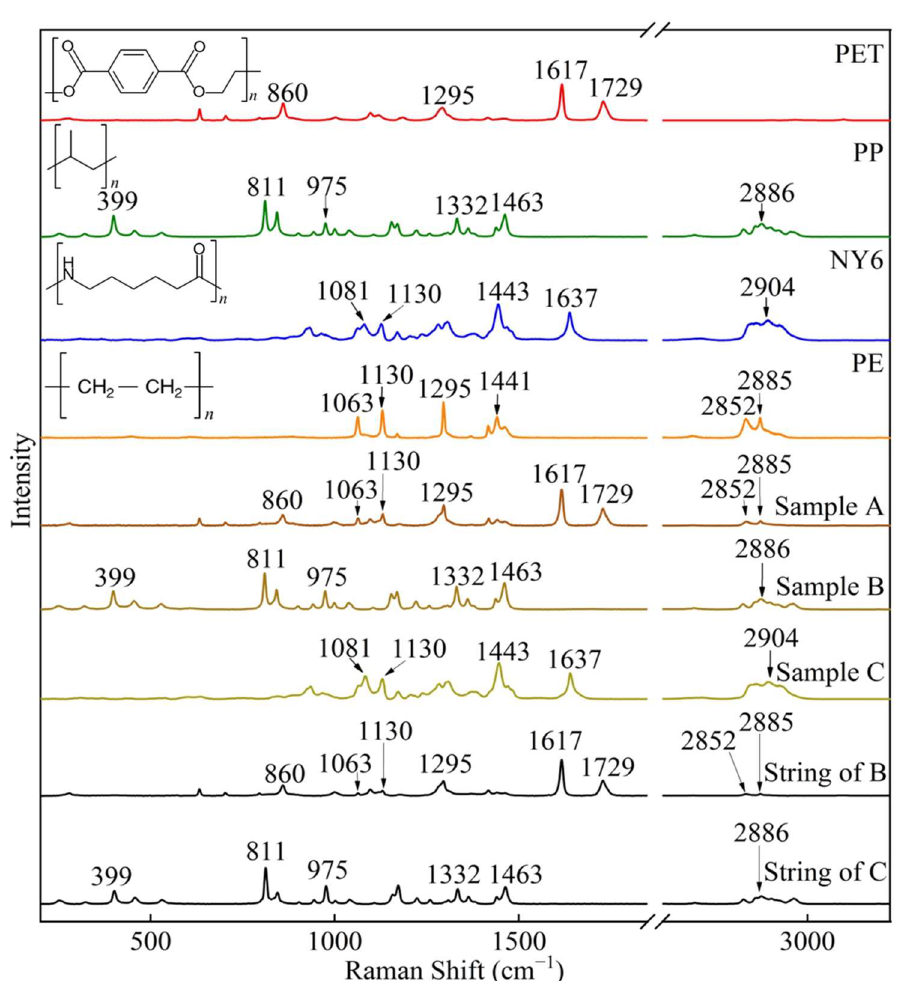
Figure 2. Raman spectra of the standards, filter bags, and strings. PET, PP, NY6, and PE were standard Raman spectra in database. Sample A, Sample B, Sample C, String of B, and String of C represent the mean spectra.